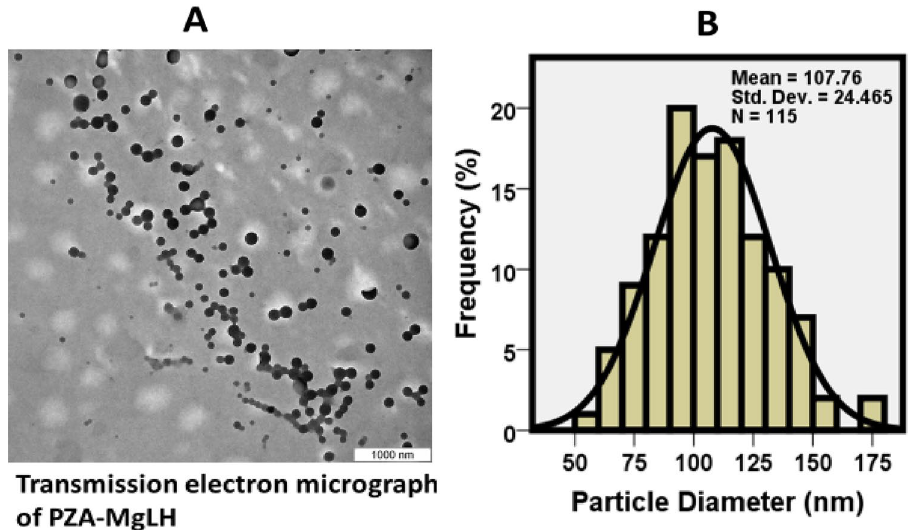
Figure 5. ( A ) Transmission electron micrograph of PZA-MgLH with a scale bar of 1000 nm and ( B ) particle size distribution of around 107 nm for PZA-MgLH obtained using ImageJ